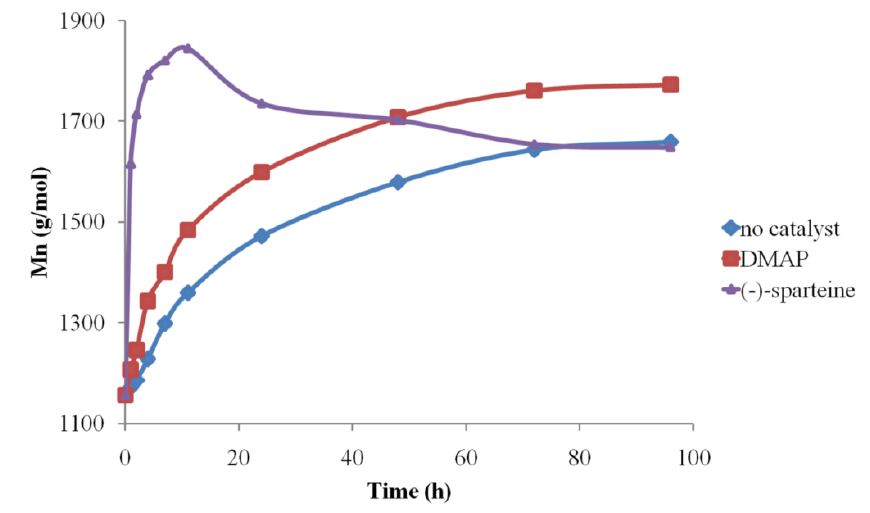
Figure 11. Organocatalyst influence in DMF over M n evolution (#4, 5, 6) .